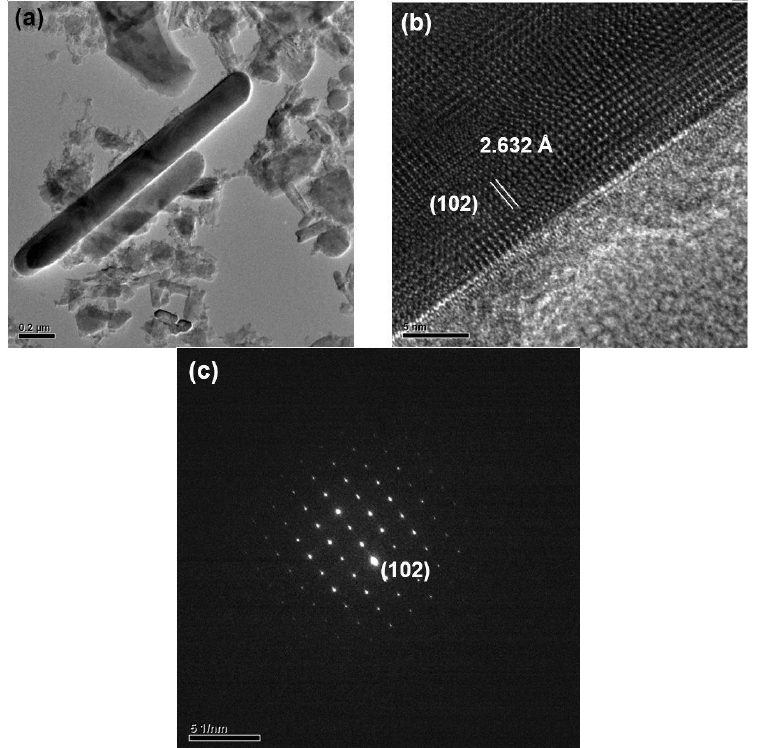
Figure 4. ( a ) TEM image; ( b ) HRTEM image; and ( c ) SAED pattern of a bar-like particle (showing it to be Ca-α-SiAlON:Eu 2+ ) in a product synthesized with Ca:Al:Si:Si 3 N 4 :Eu 2 O 3 :NaN 3 :NH 4 Cl = 0.25:1.0:0.25:0.25:0.02:3.5:0.6.